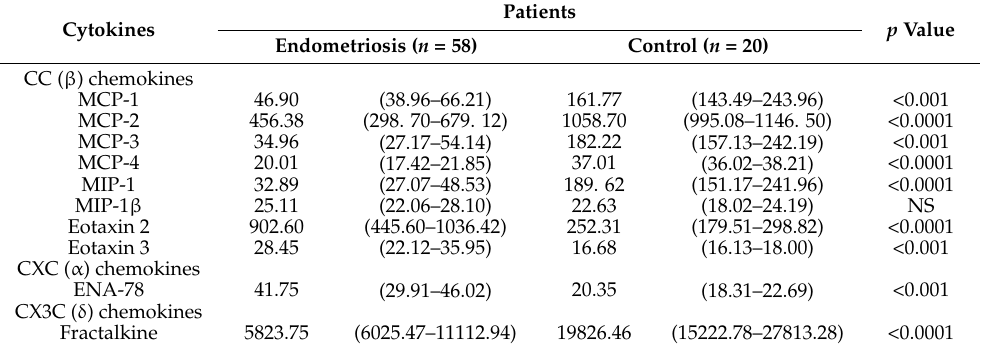
Table 1. Peritoneal level of the studied chemokines in women with endometriosis and women from the reference group.